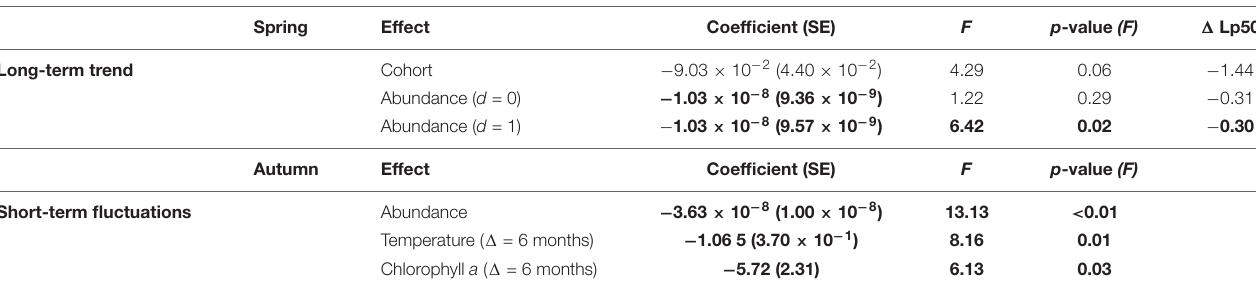
Results are only presented for seasonal PMRN midpoints showing either long-term trend or short-term fluctuations. For each coefficient, F-statistic value (F) and associated p-value are given. Regarding the long-term trend analysis, the change in L p are shown in